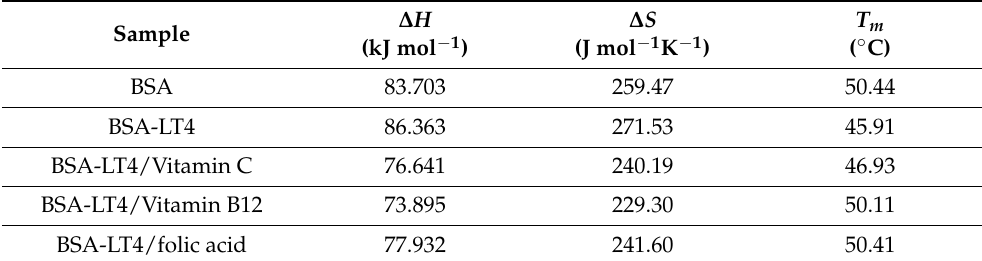
The plot of lnK eq vs. 1/T (the van’t Hoff plot) is represented in Figure 7C. The denaturation of the BSA-LT4 complex in the presence of the vitamins is an endothermic process. The slope of the straight line gives the − ∆ H unf /R value and the Y-intercept gives the ∆ S unf /R value. The thermodynamic fingerprint of protein stability is given in Table 2. Table 2. The thermodynamic fingerprint of BSA-LT4 denaturation in the presence of vitamins.